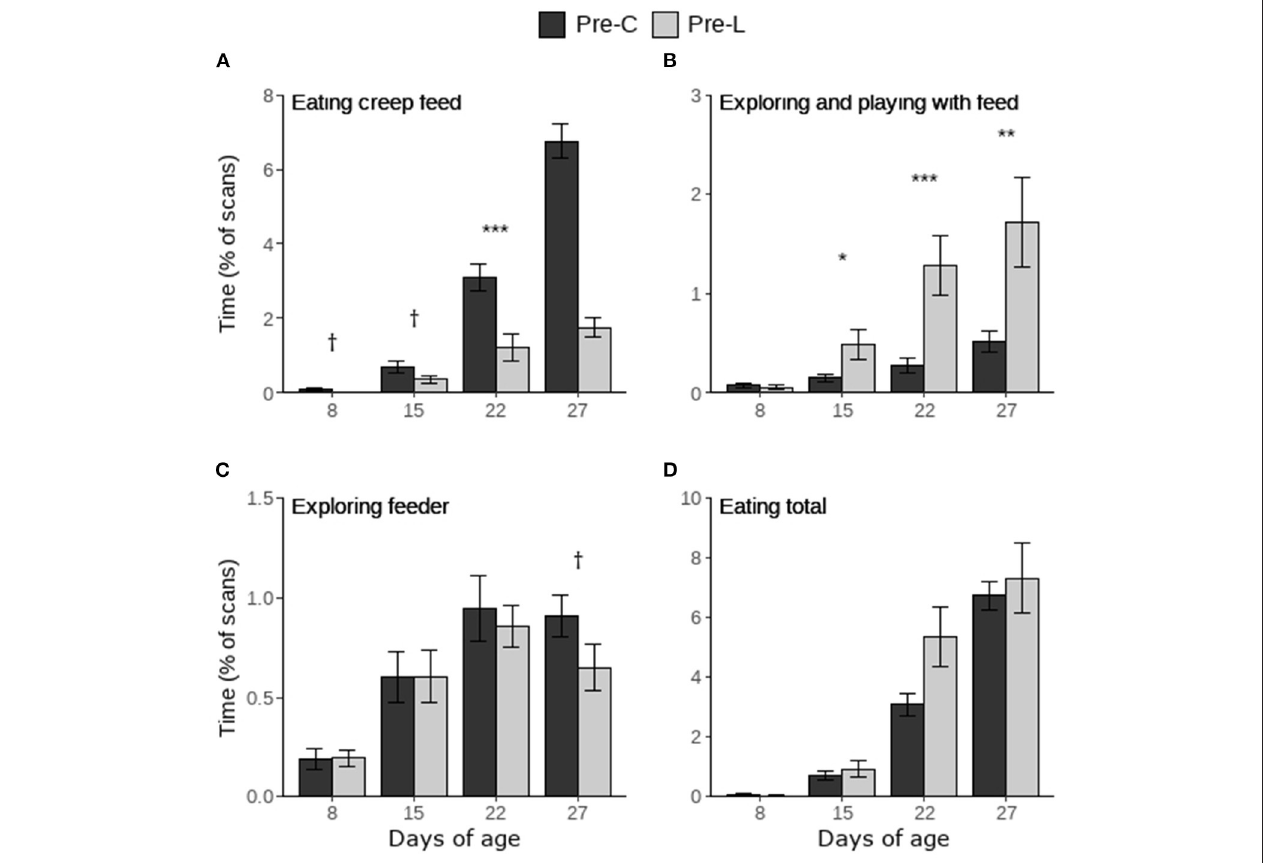
FIGURE 3 | Time spent on feed-directed behaviors scored during the pre-weaning home pen observations of piglets having access to either only creep feed (Pre-C) or creep feed and live black soldier fly larvae (Pre-L). “Eating total” includes the time spent eating creep feed and eating larvae. Per day, treatment effects are indicated as † ( p < 0.1), *( p < 0.05), **( p < 0.01), or ***( p < 0.001). Data are presented as pen means ±